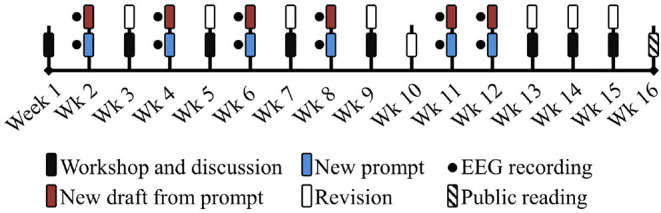
Creative writing workshop 1. Pilot study. Timeline for the EEG recording sessions in the creative writing workshop: Talleres de escrituras.